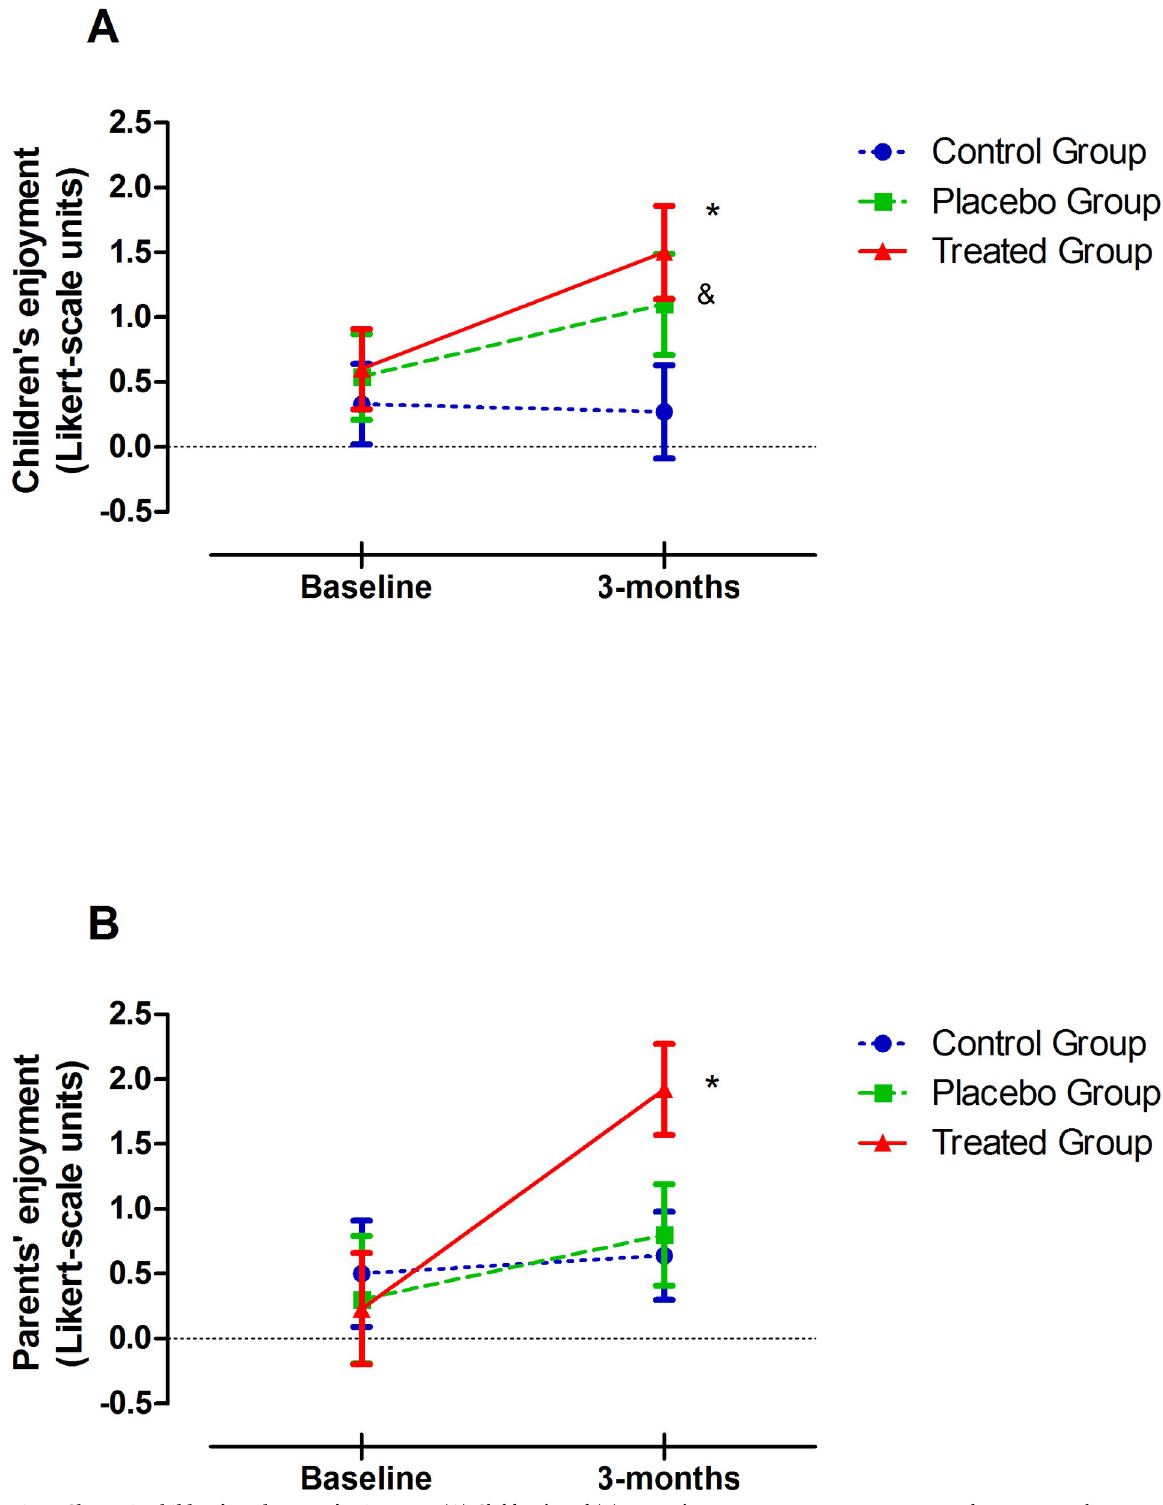
Fig 2. Change in children’s and parents’ enjoyment. (A) Children’s and (B) parents’ enjoyment. Enjoyment was assessed on 7-point Likert-type scales, where—3 was the least enjoyment, + 3 was the most enjoyment, and 0 was neutral. Values were measured at baseline and in the final interviews. The data are presented as the mean ( ± SD). Wilcoxon test was performed to compare the differences between the baseline and final